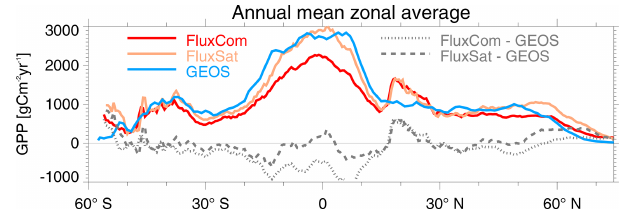
Figure 6. Zonal mean of multiyear (2010–2015) average GPP from FluxCom, FluxSat, and